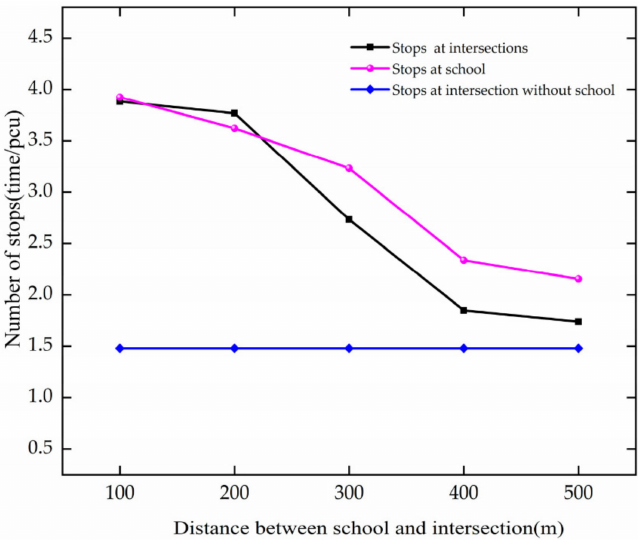
Figure 22. Variation trend of stops with